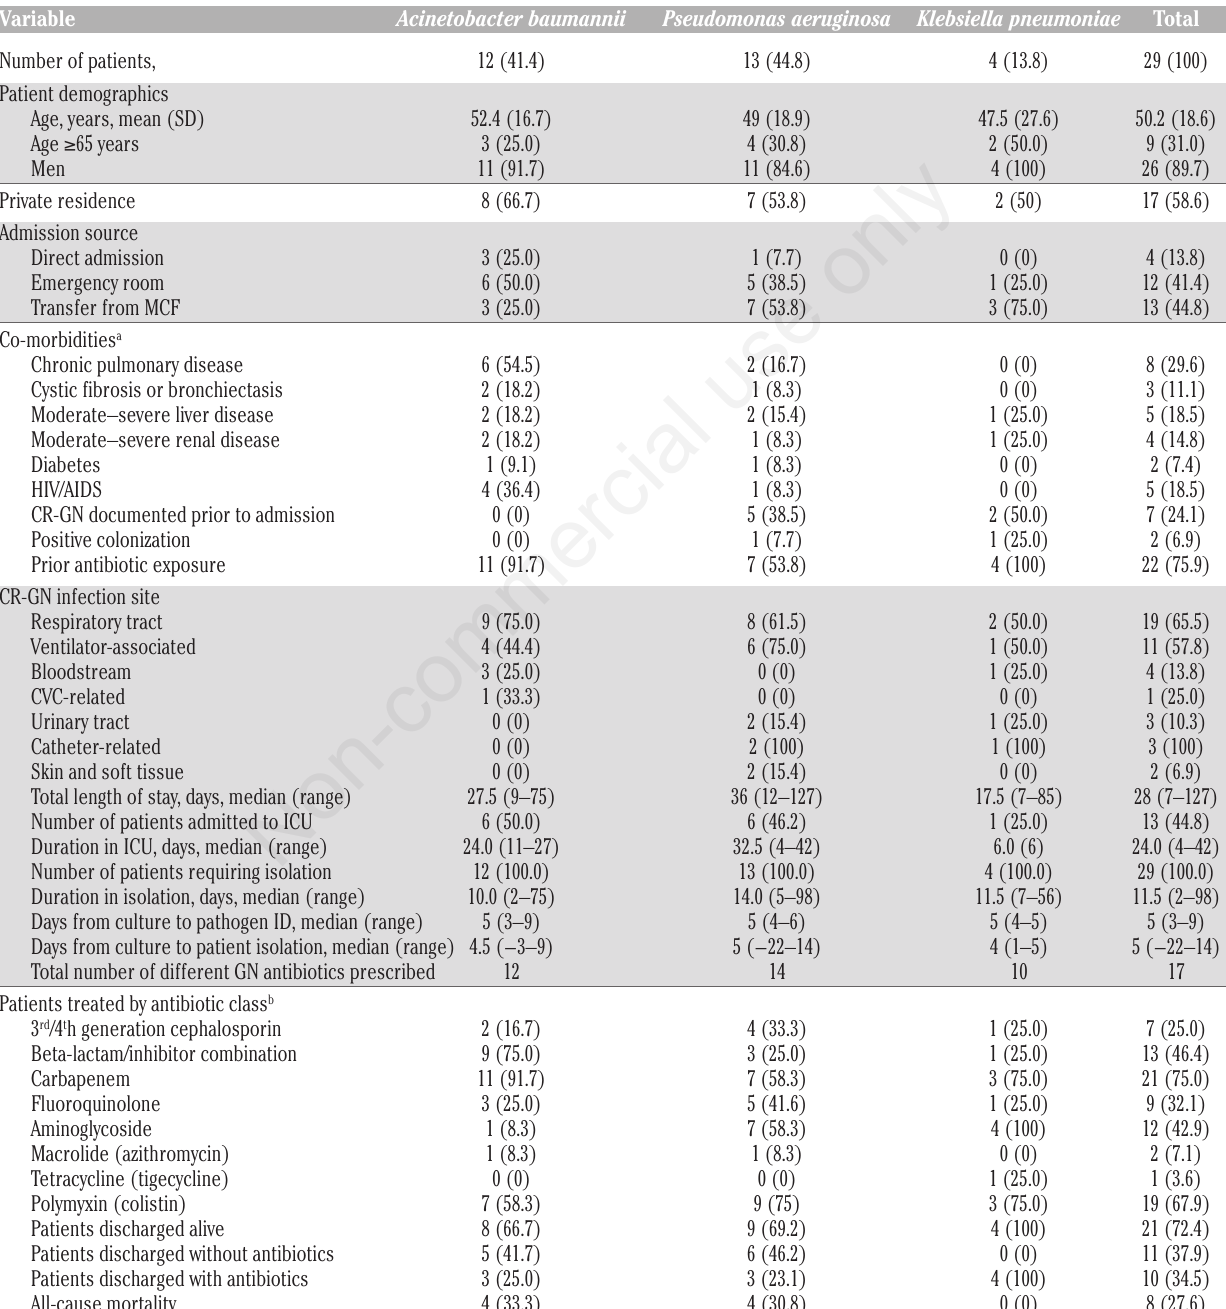
Table 1. Clinical characteristics by pathogen of 29 patients with documented carbapenem-resistant Gram-negative infections from an Italian infectious diseases referral centre (November 1 st , 2015 – October 31 st ,